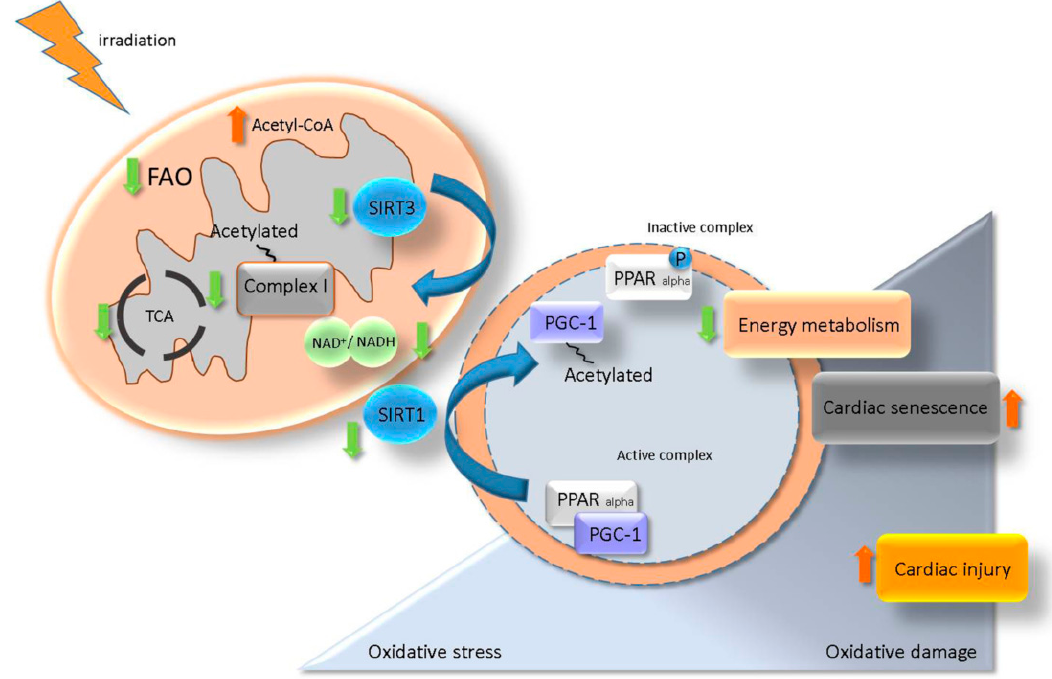
Figure 9. A proposed model for the role of SIRT / PGC-1 / PPAR alpha network in regulation of radiation-induced cardiac injury. Irradiation impairs the mitochondrial complex I activity resulting in NAD + homeostasis alteration. A change in the level of NAD + / NADH reduces the activity of SIRT3 and enhances the acetylation state of mitochondrial proteins. NAD + / NADH alteration also a ff ects the SIRT1 activity and impairs the PGC-1 / PPAR alpha transcription complex via an increased level of acetylated (inactive) PGC-1. Deactivation of PGC-1 / PPAR alpha is associated with a low level of myocardial metabolism, elevated oxidative damage and accelerated senescence contributing to the radiation-induced cardiac injury.